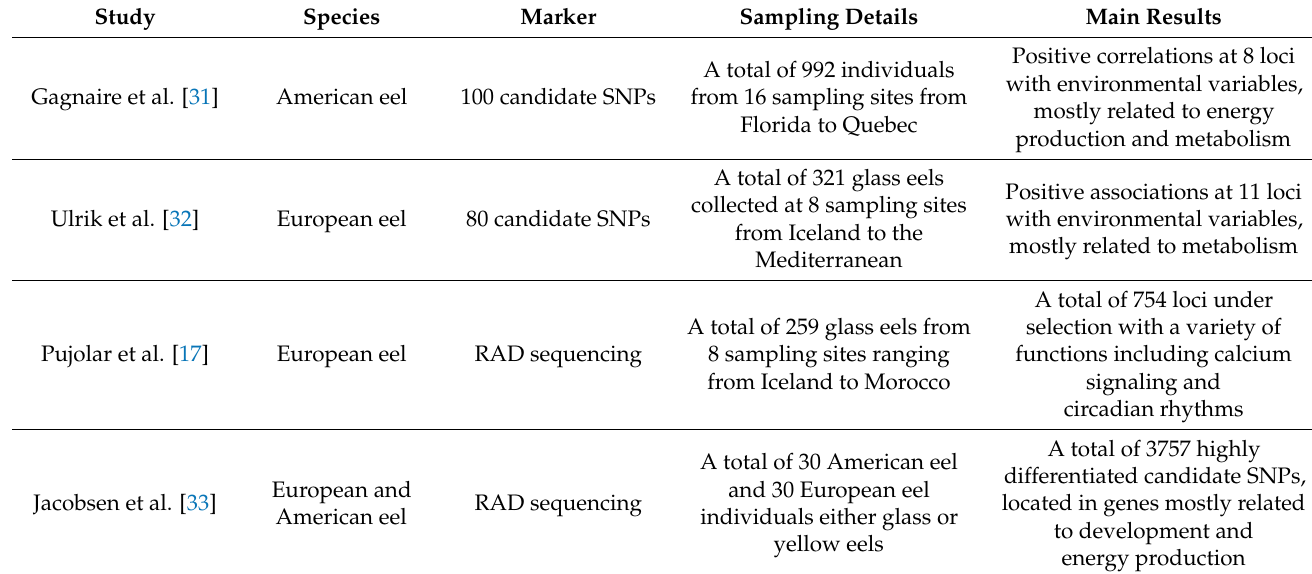
Table 1. Summary of all selection studies on North Atlantic eels including species studied, genetic markers used, sampling details and main